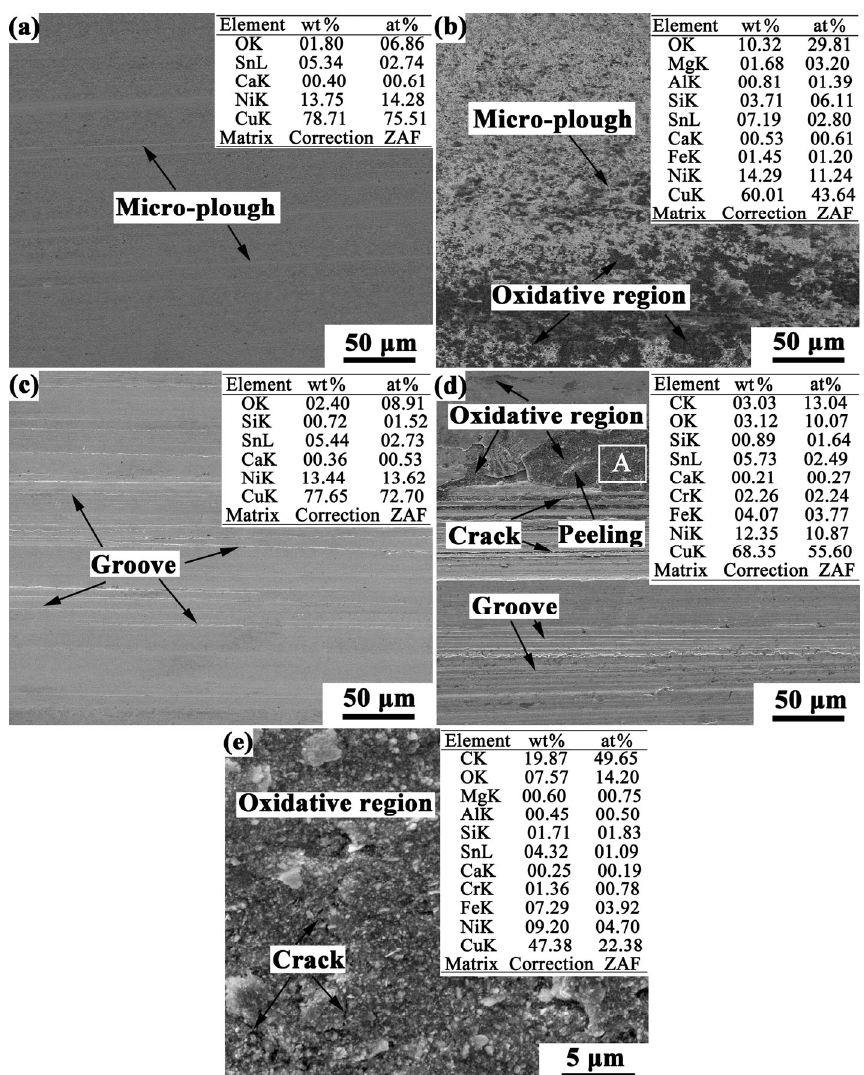
Fig. 10 SEM images of worn-surfaces of Cu–15Ni–8Sn–0.8Nb alloy under different sliding conditions: (a) 50 N, 0.13 m/s; (b) 50 N, 2.58 m/s; (c) 700 N, 0.13 m/s; and (d, e) 700 N, 2.58 m/s. Insets show EDS analysis of the corresponding worn-surfaces. ZAF correction includes the correction factors of atomic number (Z), absorption (A), and fluorescence